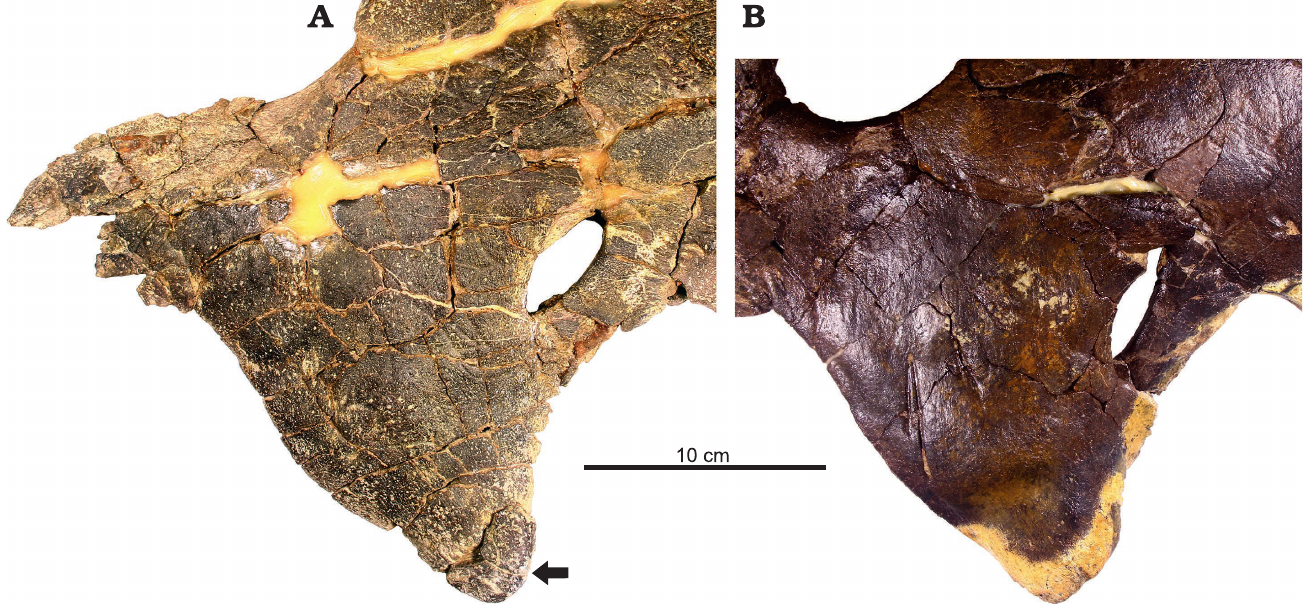
Fig. 5. Lateral views of jugals of Einiosaurus procurvicornis Sampson, 1995, MOR 456 8-8-87-1 ( A ) and eucentrosauran ( Einiosaurus procurvicornis or Achelousaurus horneri Sampson, 1995), MOR 591 ( B , mirrored), from the Campanian Two Medicine Formation, Montana, USA. Arrow indicates